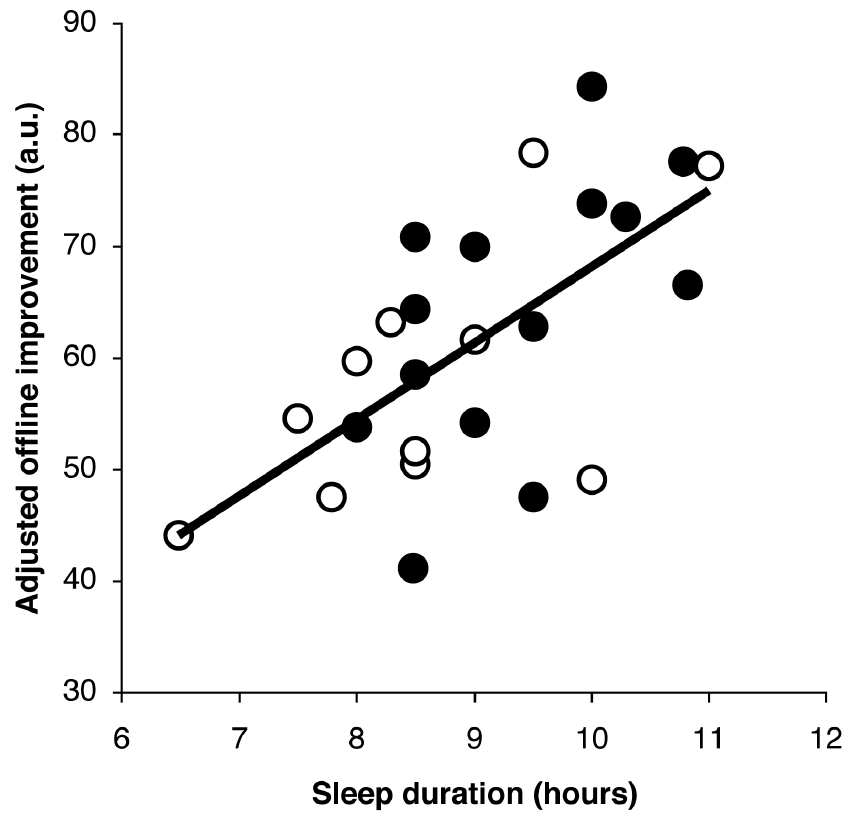
Figure 2. Sleep quantity and performance improvements. The degree of offline improvement, indicated by the performance improvement between testing days, significantly correlated with sleep duration the night after motor training (regression analysis; b =0.65, p , 0.05). The vertical axis represents the adjusted improvement in performance, ruling out the effects of age and the time between wake-up and testing on day 2, estimated from the results of the regression analysis. The horizontal axis indicates sleep duration (hours) during the night after motor training. The black and white dots represent the individual data from the 9- and 11-year-old children, respectively. The solid line is the linear regression fit.